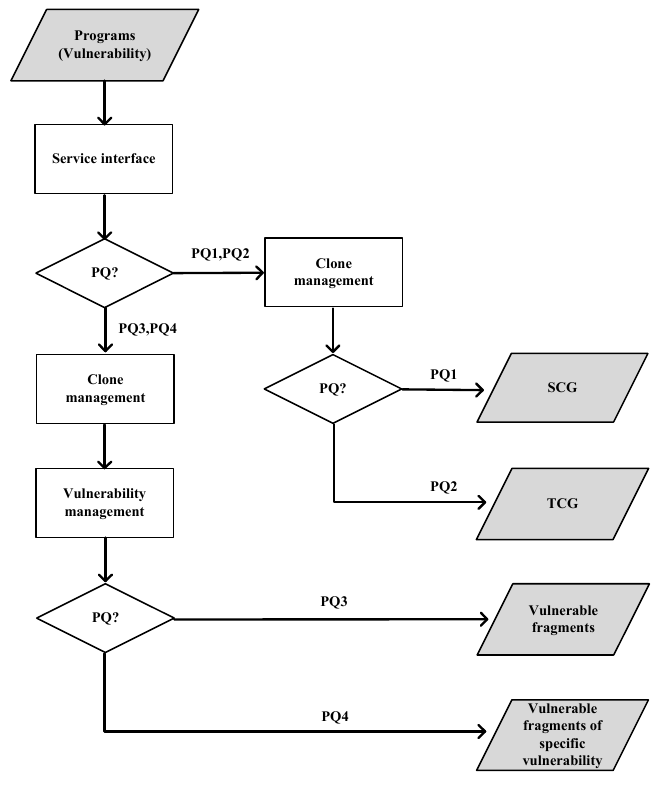
Figure 3. The flow chart of the CVMan prototype